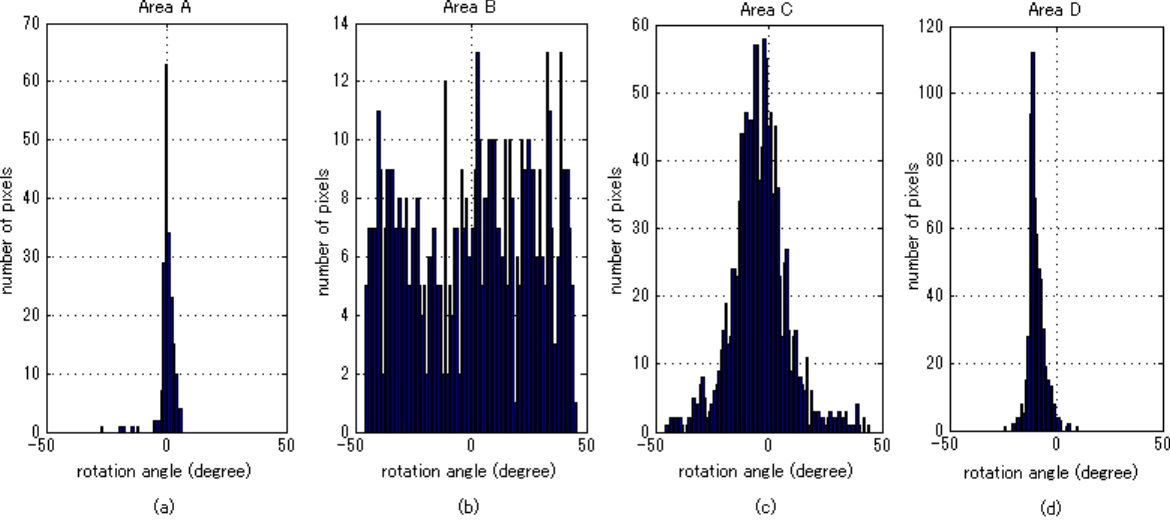
Figure 4. Rotation Angle distribution of selected areas in Figure 2. Horizontal axis is rotation angle and vertical axis is frequency. ( a ) Area A. ( b ) Area B. ( c ) Area C. ( d ) Area